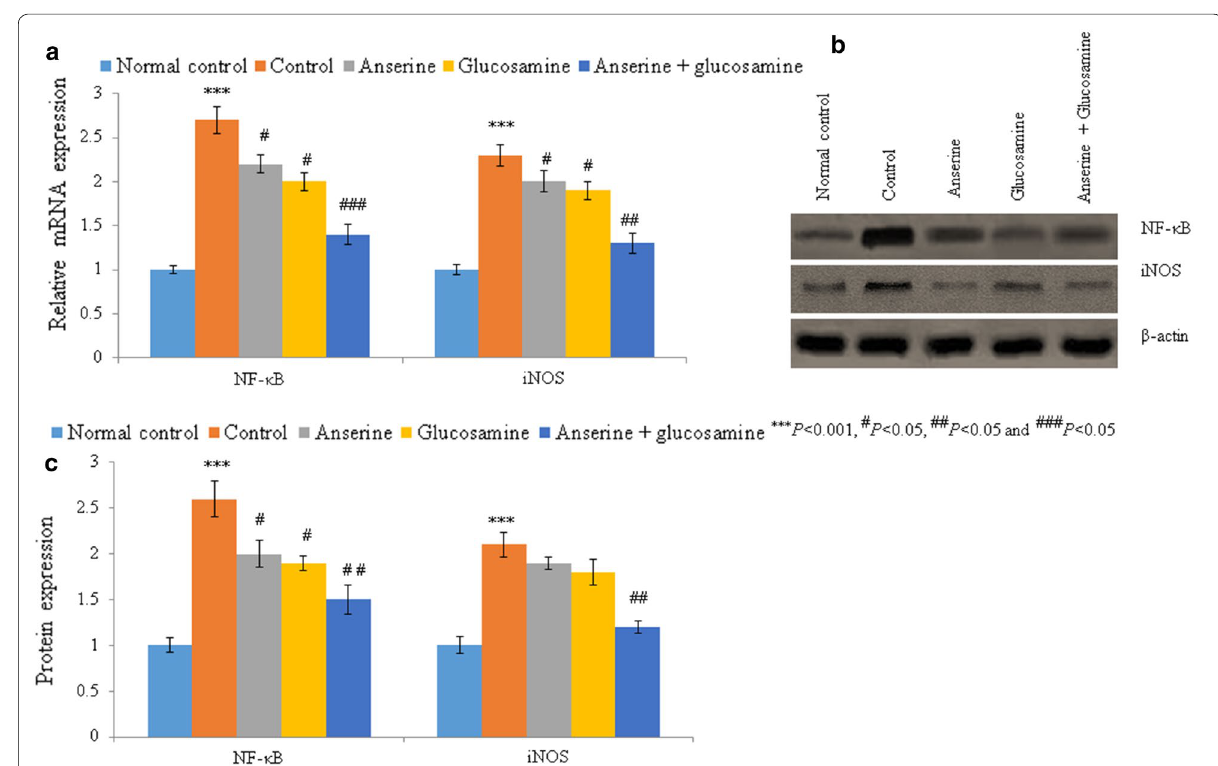
Fig. 1 Anserine plus glucosamine supplementation reduced the mRNA and protein levels of NF-κB and iNOS in synovial tissue. a mRNA levels of NF-κB and iNOS. b Western blots of NF-κB and iNOS. c Densitometric analysis of the data in